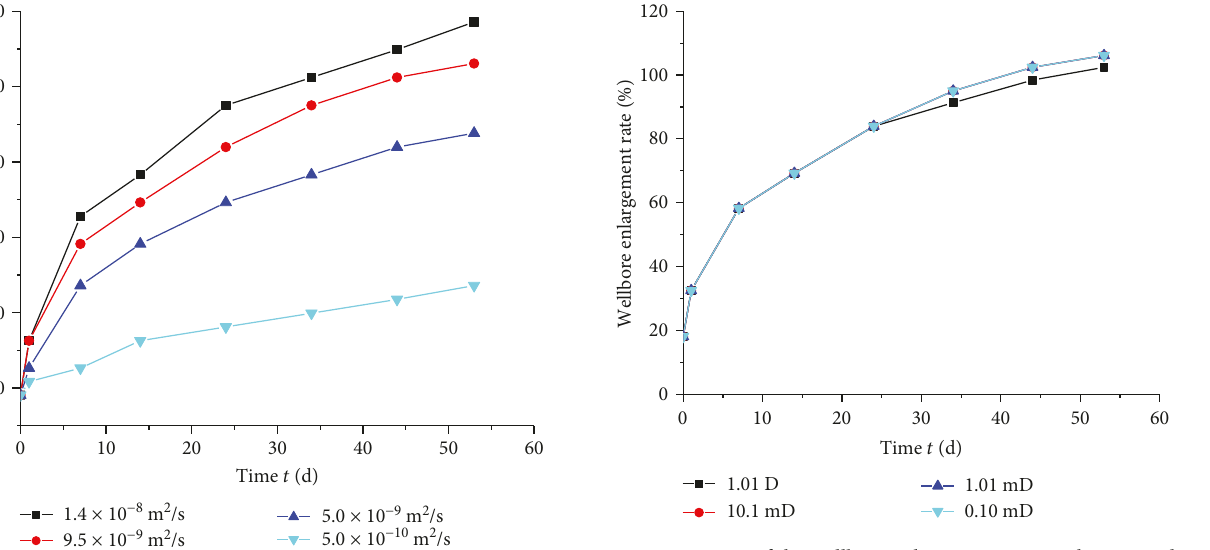
Figure 18: Curve of the wellbore enlargement rate with time under di ff erent water absorption and di ff usion coe ffi cients.